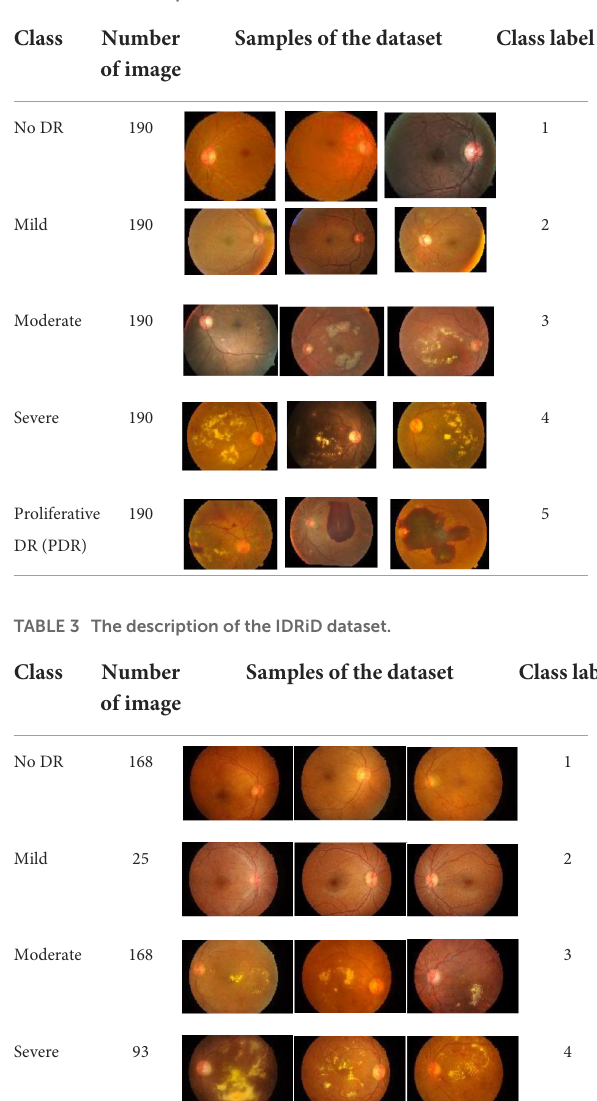
TABLE 2 The description of the APTOS-2019 dataset.